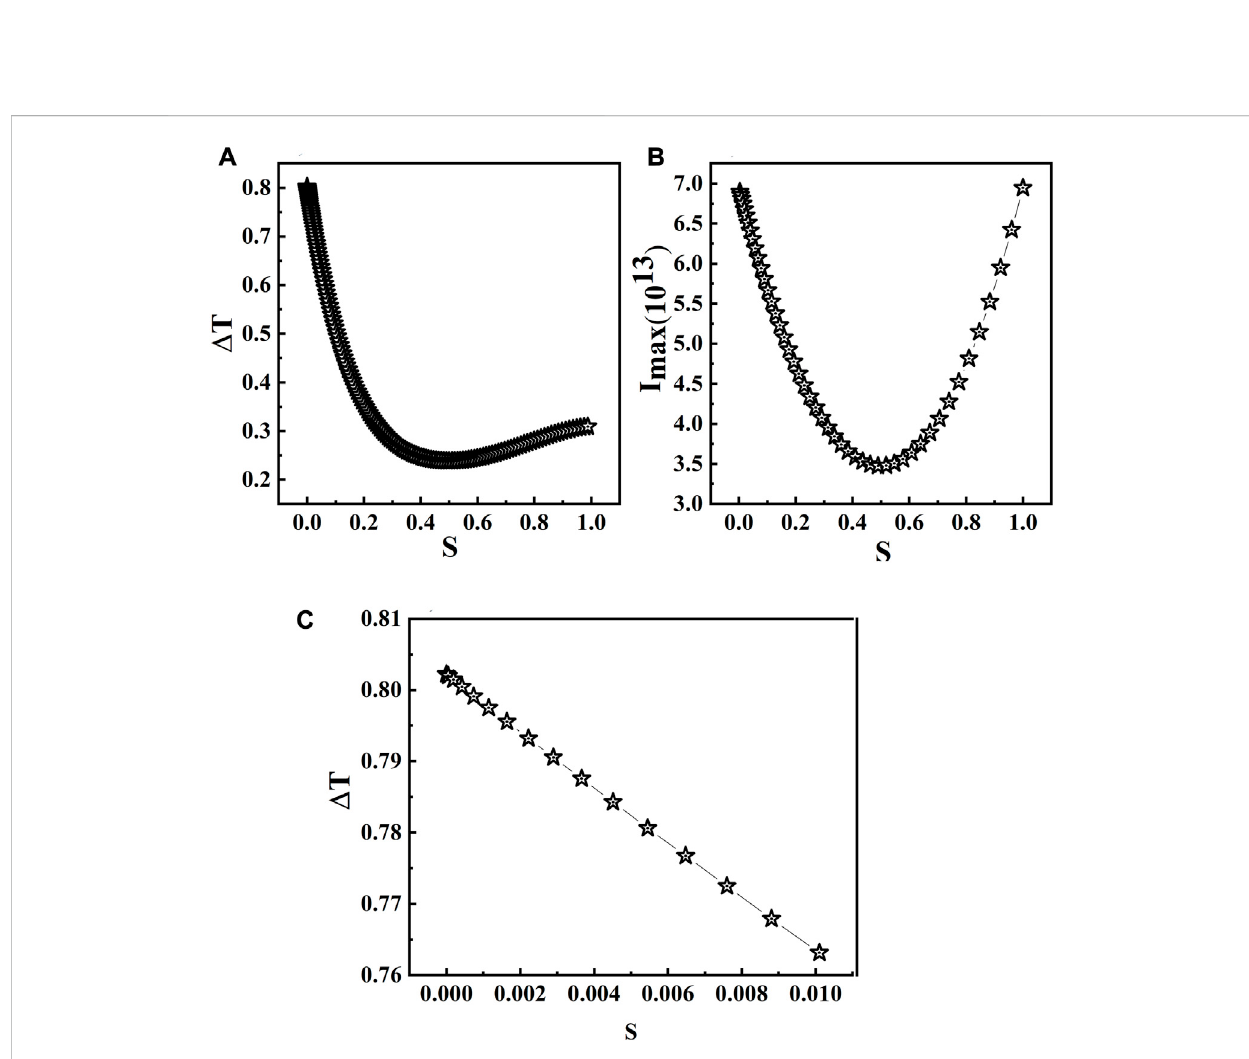
FIGURE 5 (A) Transmittancechanges ( Δ T ) asafunctionofthearea(S (cid:2) ( L p / R a ) 2 ). (B) TheintensityI max (giveninGW/cm 2 inside)ofphaseobjectasafunctionof the area (S (cid:2) ( L p / R a ) 2 ). (C) Dependence of Δ T on the HPO area when S ≤ 0 .